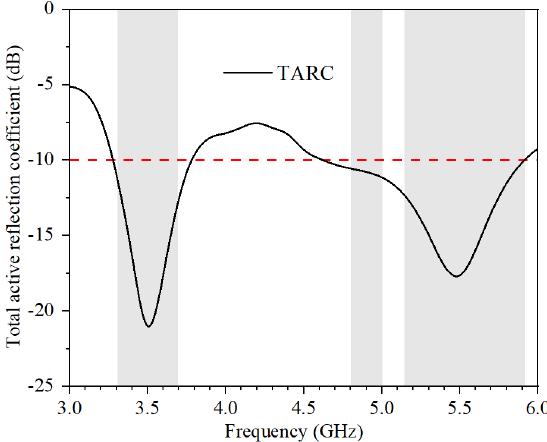
Figure 12. Calculated TARC. The radiation patterns of the proposed antenna element at 3.5 GHz, 4.9 GHz, and 5.5 GHz are shown in Figure 13. The measured co-pol and cross-pol are represented by solid and dashed lines, respectively. The cross-pol of all antennas is smaller than the co-pol. The co-pol and cross-pol of the same antenna are different at disparate frequency points. Since Ant.1 and Ant.2 have the same shape and different positions, radiation patterns are slightly similar, but not identical.